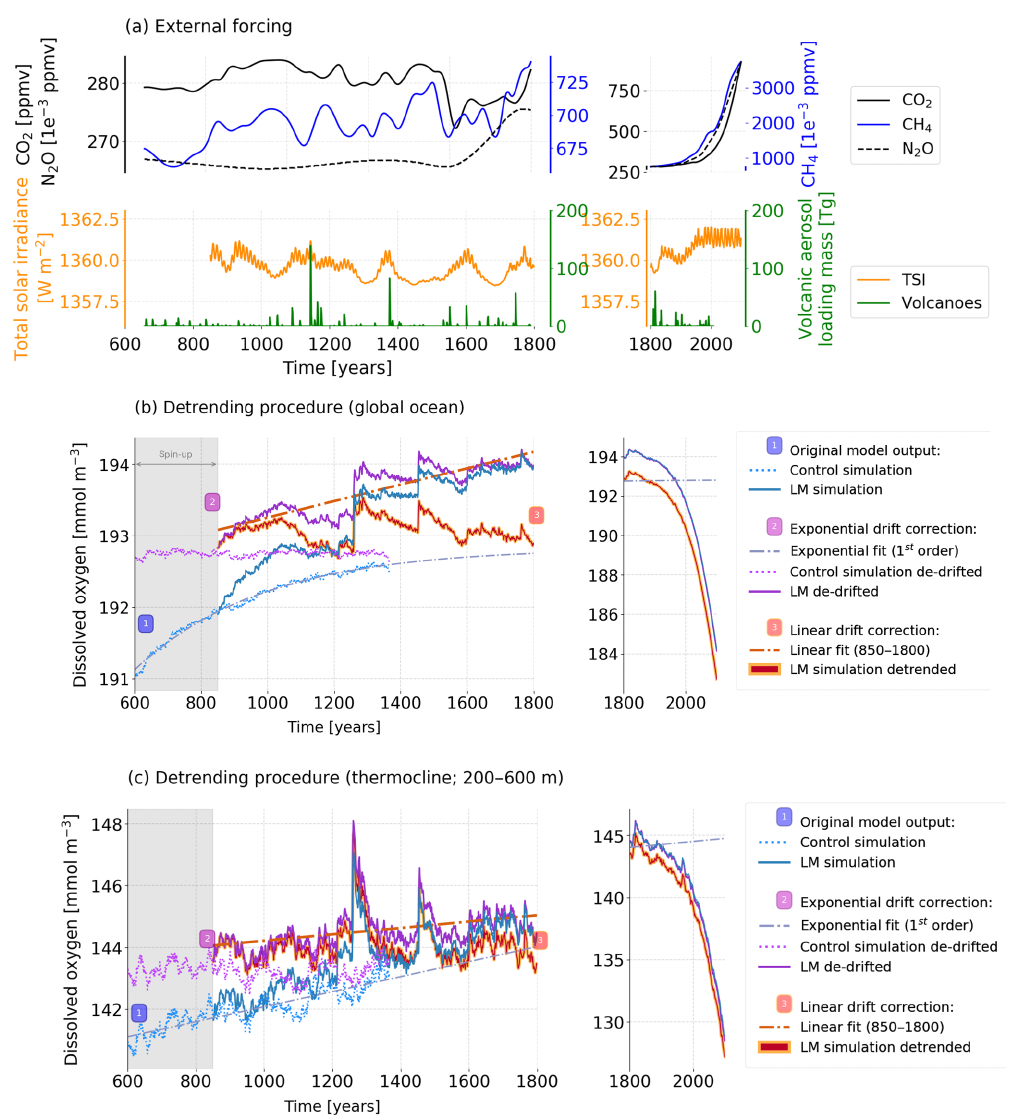
Figure A1. (a) Time series of the main external forcings applied to the forced simulation: total solar irradiance (Wm − 2 ) at the top of the atmosphere in orange, stratospheric volcanic aerosol load (Tg) in green and the greenhouse gases CO 2 (solid black line), N 2 O (dashed black line) and CH 4 (solid blue line) (ppmv). Illustration of the two-step procedure to remove model drift and millennial-scale trends at each grid point shown in (b) the global mean ocean and (c) the thermocline (200–600m). The original, annually averaged outputs from the control (CTRL) and the forced simulations are shown by dashed and solid blue lines, respectively (1). The results of the CTRL are fitted by an exponential function with one timescale and extrapolated towards equilibrium (dashed line). The exponential curve is subtracted from and the equilibrium value added to the original outputs to obtain the purple curves (2) (dotted: CTRL, solid: forced simulation). The remaining multi-millennial trend in the forced simulation is removed using a linear fit (850–1800CE), leading to the red curve